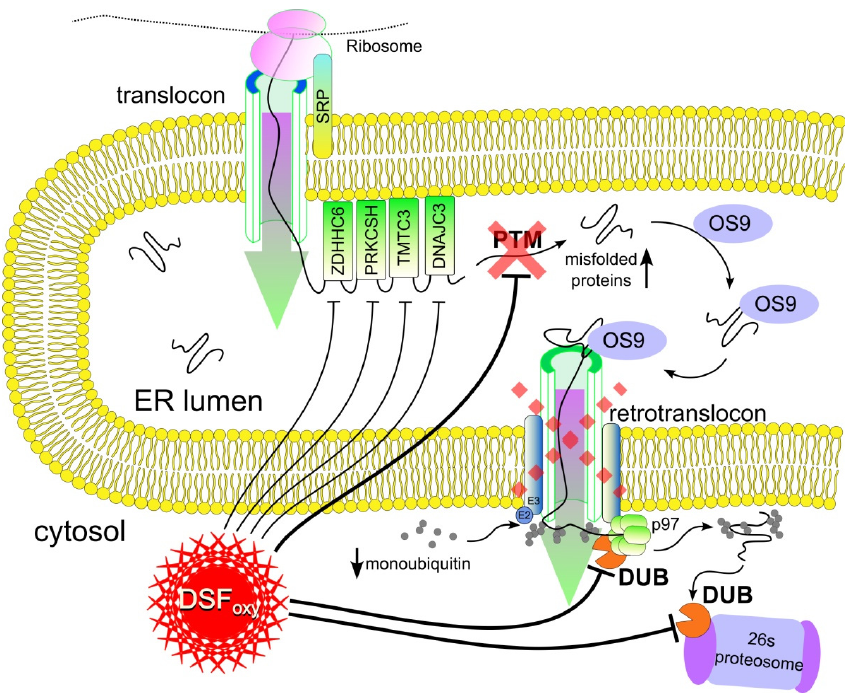
Figure 5. Scheme representing the proposed mechanism of the cytotoxic action of DSF oxy-derivatives, the key point of which is the suppression of the UPS mediated by DUB damage, followed by inhibition of retrotranslocation of proteins across the ER membrane into the cytosol, the accumulation of misfolded proteins in the ER, and the initiation of paraptosis-like cell